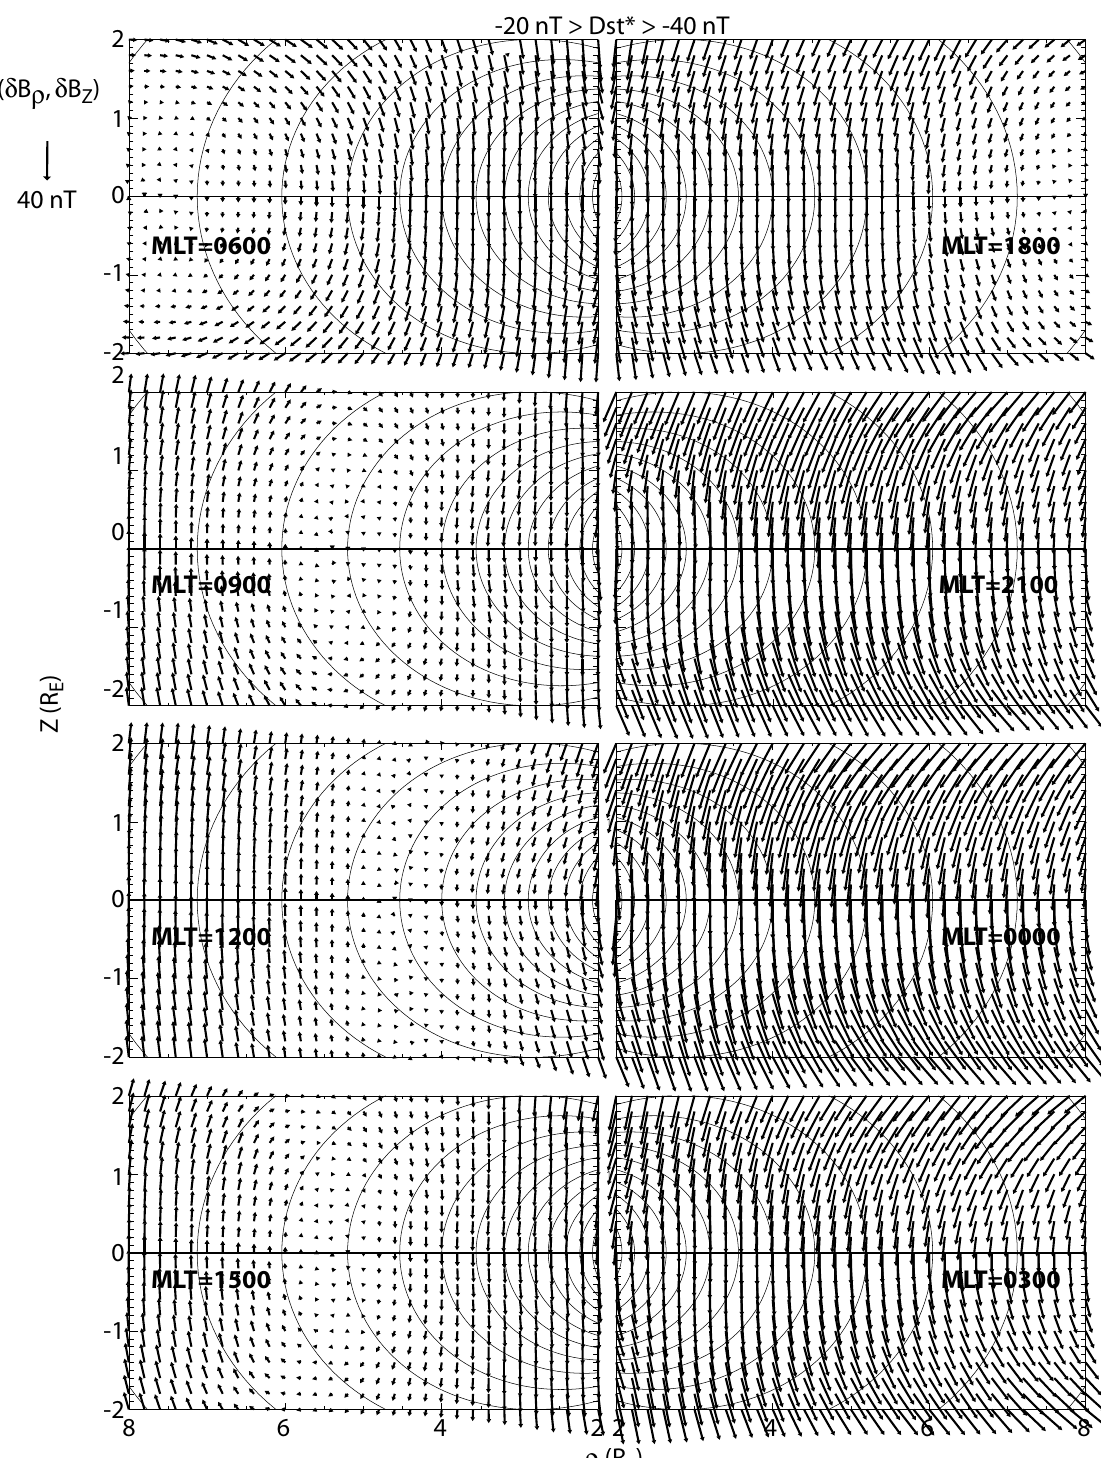
Fig. 4a. Meridional projection of the perturbation magnetic field arrows at equally spaced grids with superimposed dipole field lines in the meridian plane in each of the 8 magnetic local time bins and for each of the four D st * range: (a) − 20nT >D st * > −